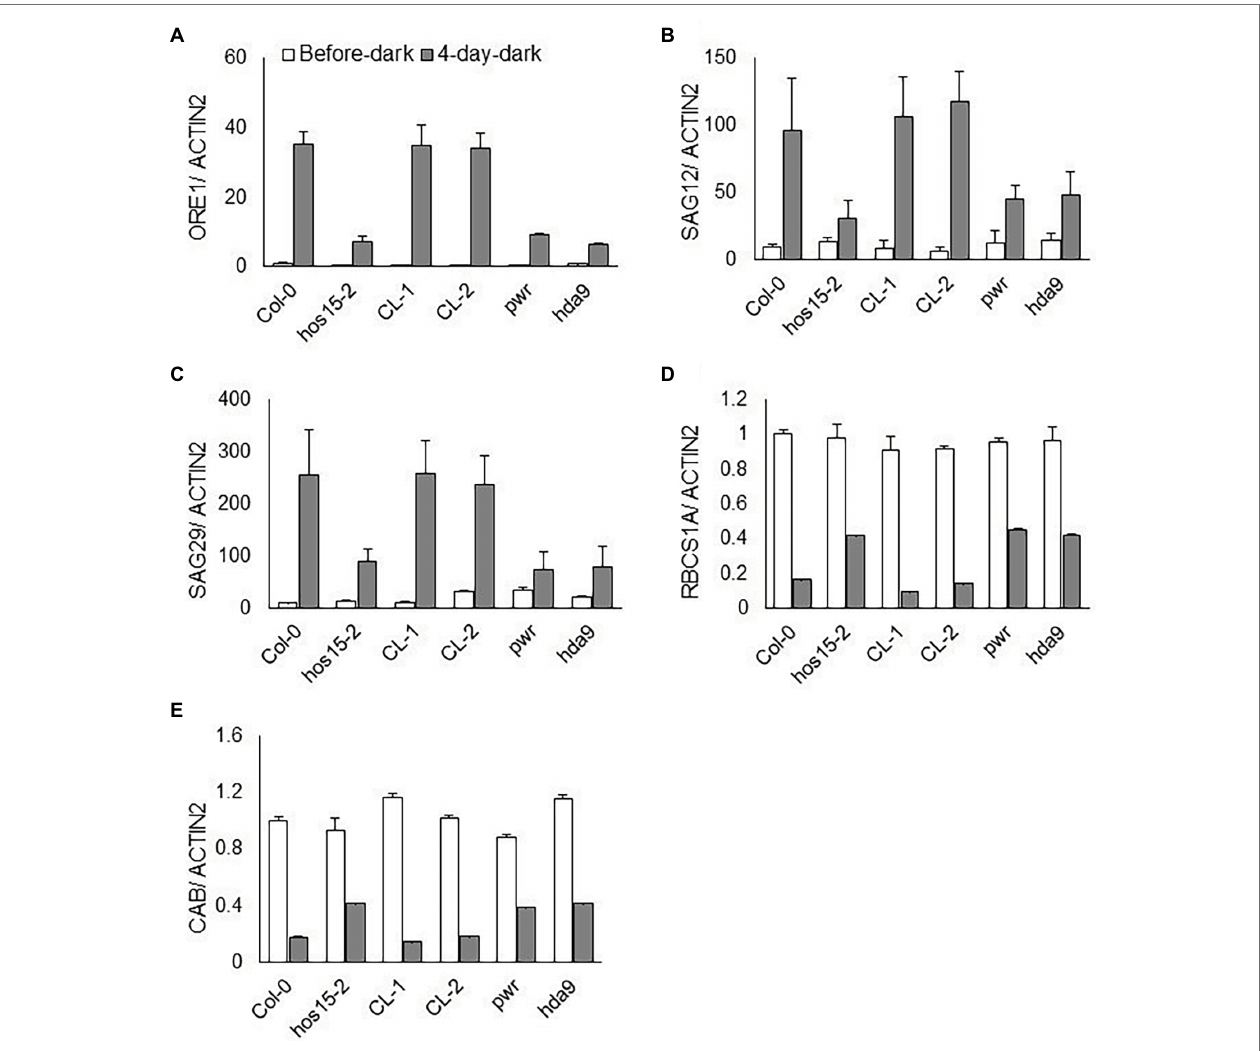
FIGURE 4 | HOS15 differentially regulates senescence- and photosynthesis-related genes during dark-induced senescence. Comparative expression level analysis of senescence- and photosynthesis-related genes. (A–E) The transcript level of senescence-related genes ORE1 , SAG12 , and SAG29 and of photosynthesis- related CAB1 and RBCS1A genes before and after dark stress. Cauline leaves of 24-day-old plants were sampled before and after 4 days of dark stress for RNA extraction. The transcript levels were quantified through qRT-PCR and normalized to Col-0 before dark stress. ACTIN2 was used as the normalization control. Error bars show SD of independent means of three biological